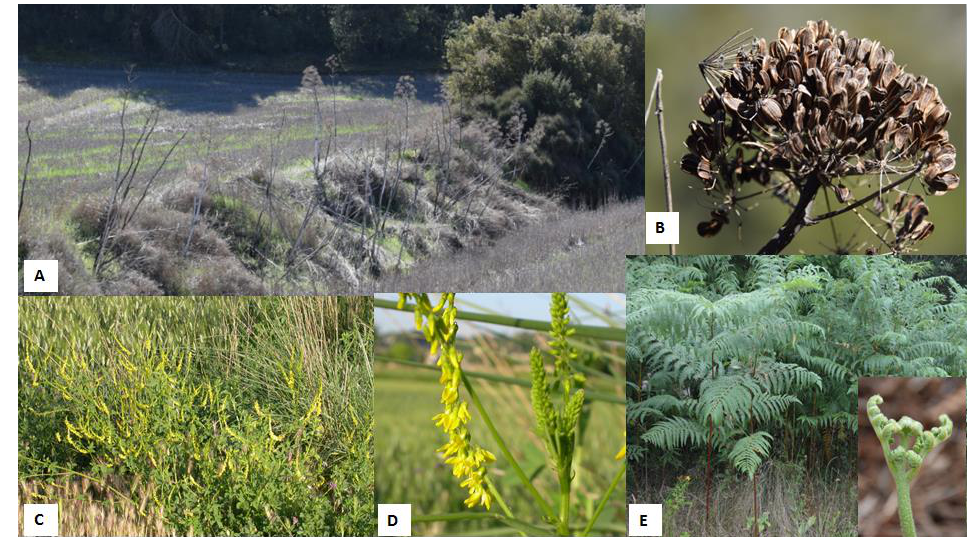
Figure 1. Some examples of plants associated with haemorraghic disorders. ( A ) Giant fennel ( Ferulla communis ) on an embankment. ( B ) General aspect of fruits of giant fennel. ( C ) Sweet clover ( Melilotus officinalis ) grown on the edge of a wheat field. ( D ) Flower of M. officinalis . ( E ) General aspect and fronds of bracken fern ( Pteridium aquilinum ). The small picture shows a “fiddlehead” sprouting.